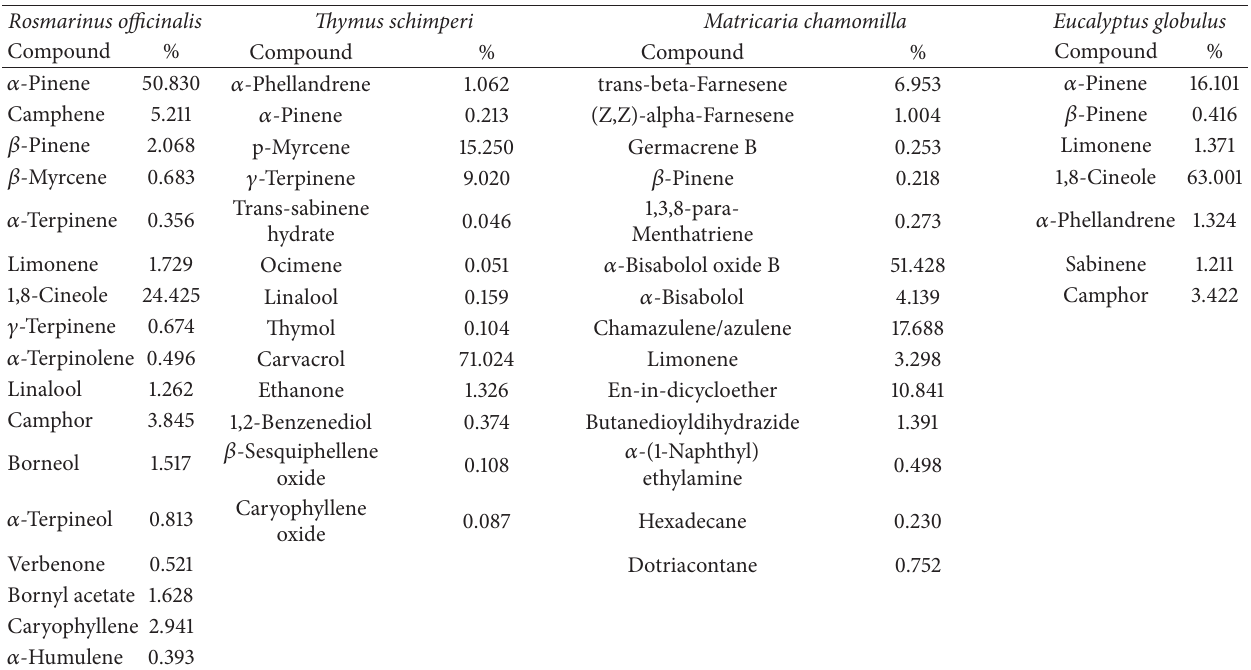
Table 1: Chemical composition of essential oils of Rosmarinus officinalis , Thymus schimperi , Matricaria chamomilla , and Eucalyptus globulus [14].